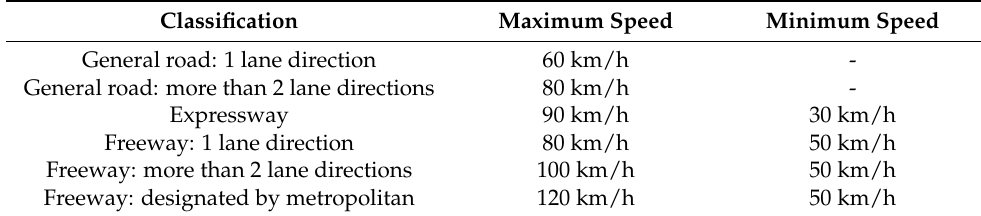
Table 1. Current statutory maximum speed limits in South Korea.